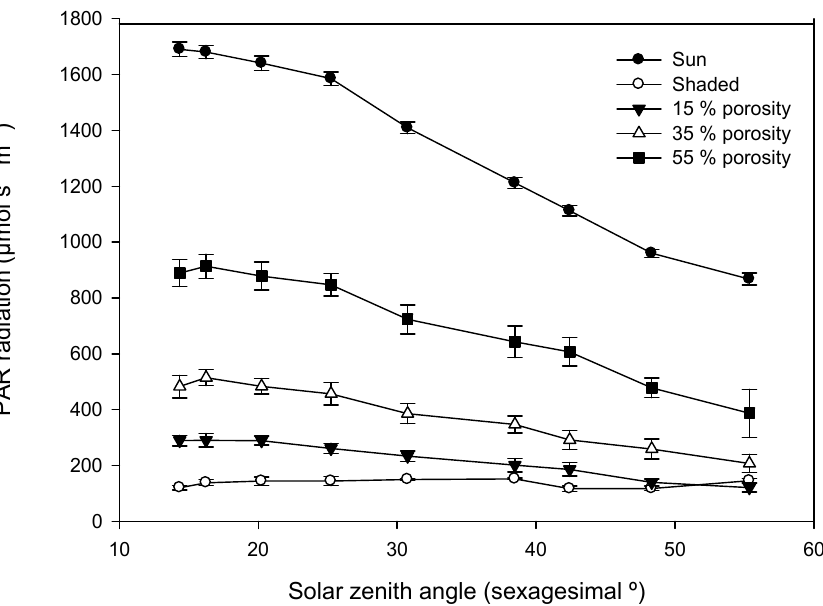
Figure 4. PAR measures evolution depending on solar zenith angle and radiation exposure under porous nets.